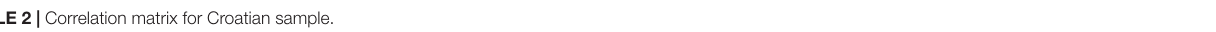
TABLE 2 | Correlation matrix for Croatian sample.